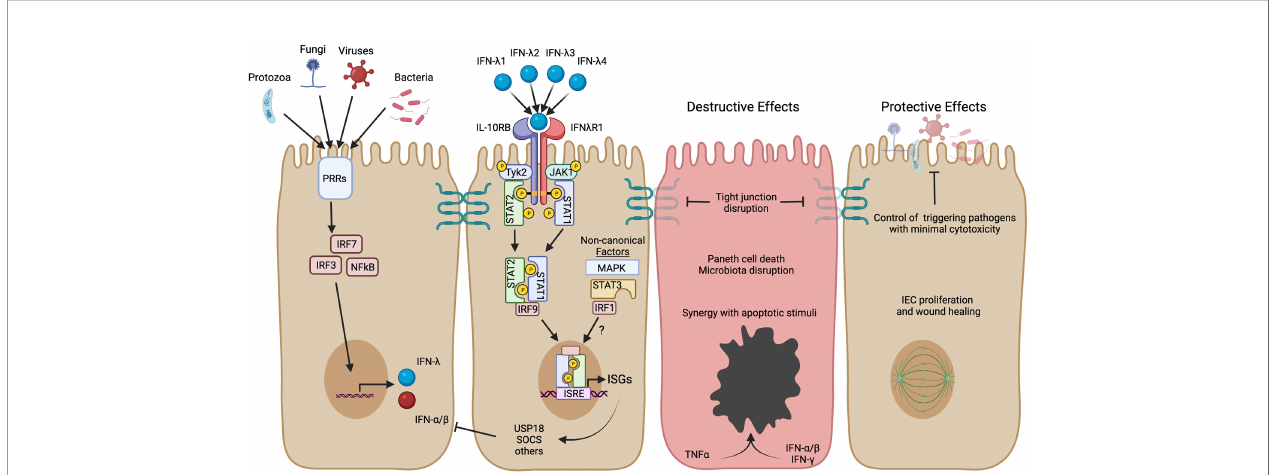
FIGURE 1 | IFN- l induction, signaling, and potential roles in IBD. Production of IFN- l can be stimulated by microbial activation of pattern recognition receptors (PRRs) and stimulation of downstream transcription factors (IRF3, IRF7, NF k B). These same transcription factors can also stimulate IFN- a / b , but IECs are able to preferentially produce IFN- l (19). The four subtypes of human IFN- l bind to the heterodimeric IFN- l receptor to activate JAK/STAT signaling and transcription of ISGs. IFN- l activates the canonical heterotrimeric transcription factor ISGF3 (STAT1, STAT2, and IRF9) to upregulate a core set of ISGs, including direct-acting antiviral effectors and mediators of negative feedback such as USP18 and SOCS genes. Other non-canonical factors such as MAPK, STAT3, and IRF1 can further in fl uence the magnitude and scope of ISGs expressed and may have distinct roles in the context of in fl ammatory disease. The fi gure highlights possible detrimental and protective roles for IFN- l in the context of IBD based on human organoid studies and mouse models of intestinal in fl ammation (see text for more detail). Created in